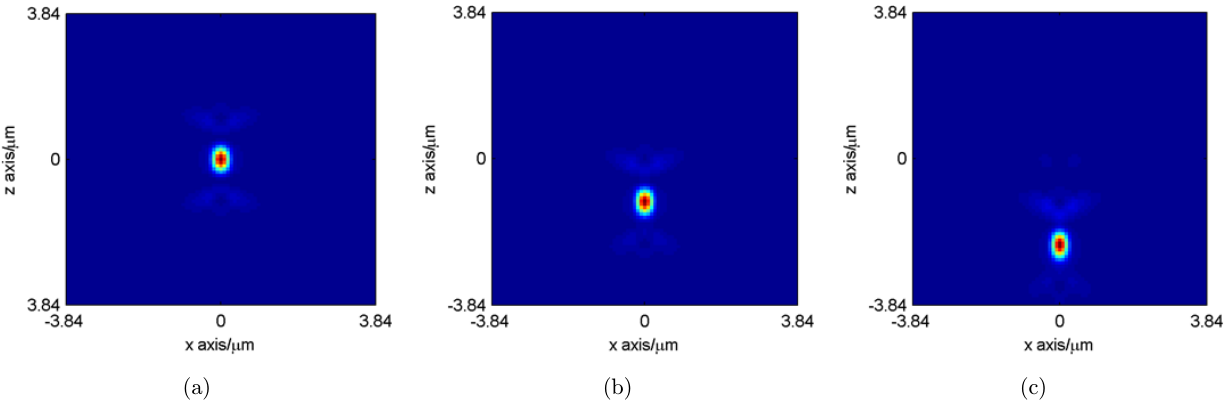
Fig. 10. The condition to suppress background from neighboring light sheets. PSF illu is the point spread function of illumination lens; PSF dete is the point spread function of detection lens; PSF over is the overall point spread function.